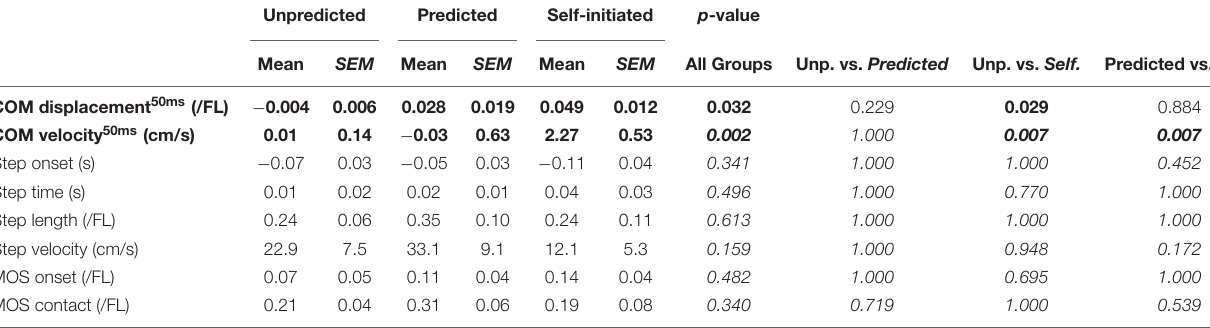
TABLE 3 | Results from the one-way analysis of variance for each change of outcome measure between the pre-training and training sessions. Unpredicted Predicted Self-initiated p -value Mean SEM Mean SEM Mean